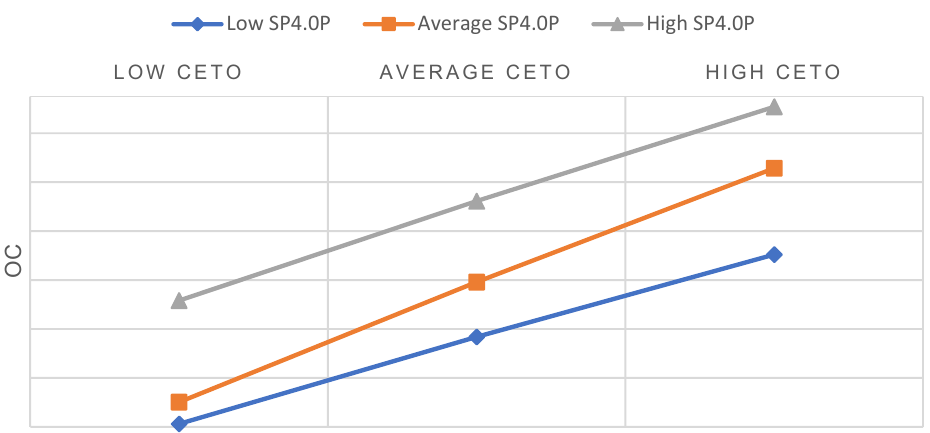
Figure 2. Graphic representation of the interaction effect.